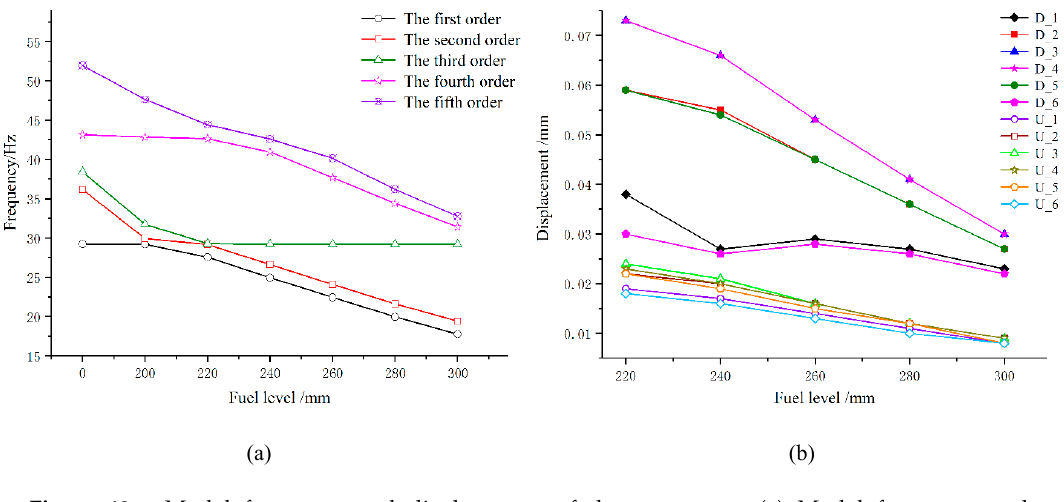
Figure 13. Modal frequency and displacement of the structure. ( a ) Modal frequency and ( b ) modal Modal frequency and displacement of the displacement.